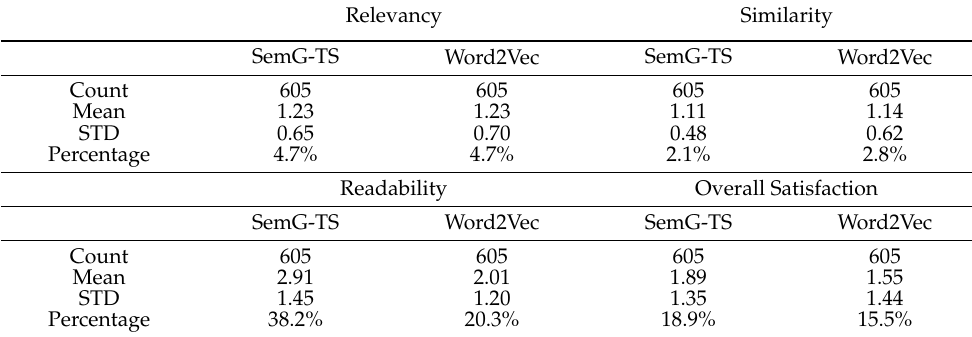
Table 11. Basic statistics of the manual